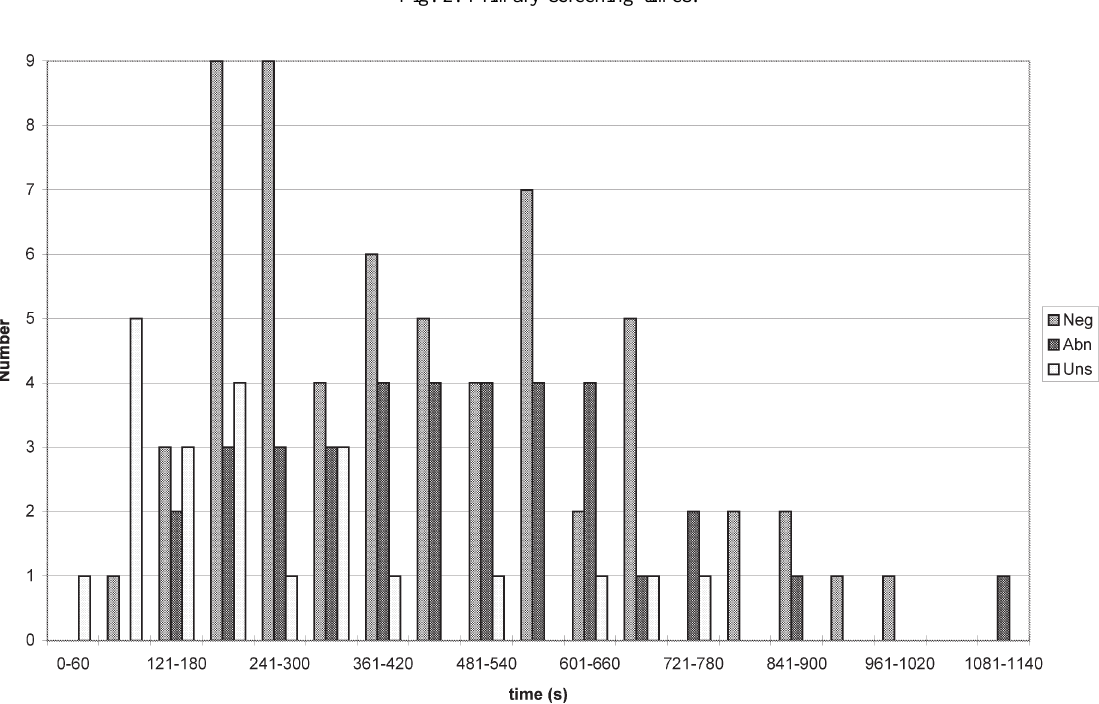
Fig. 2. Primary screening times.